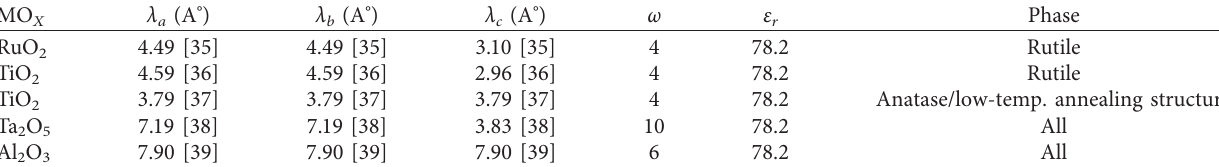
Table 1: Space-charge layer model